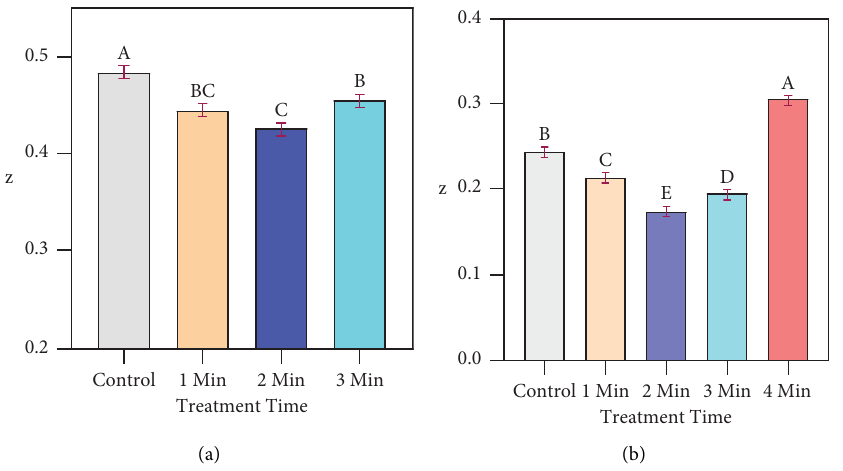
Figure 12: Efect of CAPP on synchronization index of (a) radish and (b)